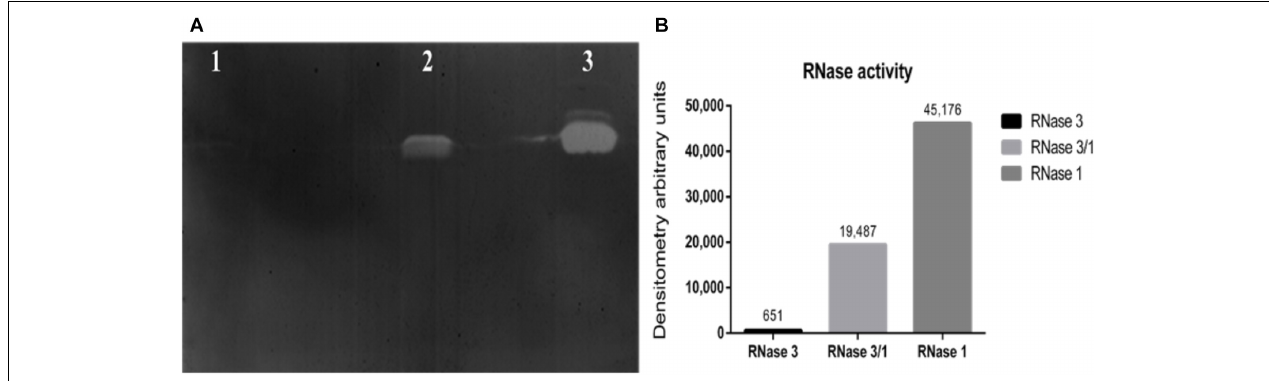
FIGURE 2 | Catalytic characterization of RNase3/1 by zymogram. (A) Activity staining gel showing the degradation of poly(U) with 20 ng of each protein. RNase 3 (lane 1), RNase 3/1 (lane 2), and RNase 1 (lane 3). (B) Densitometric analysis of the bands of the activity staining gel. Quantification was done from a scan image using Quantity One software (Bio-Rad R (cid:13) ).